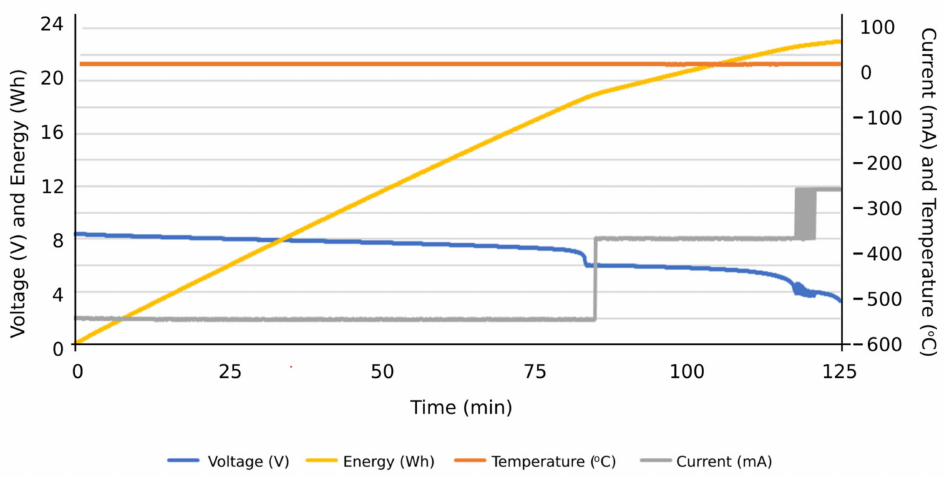
Figure 17. Results of a discharging cycle at different constant intensities: 600 mA, 400 mA, and 300